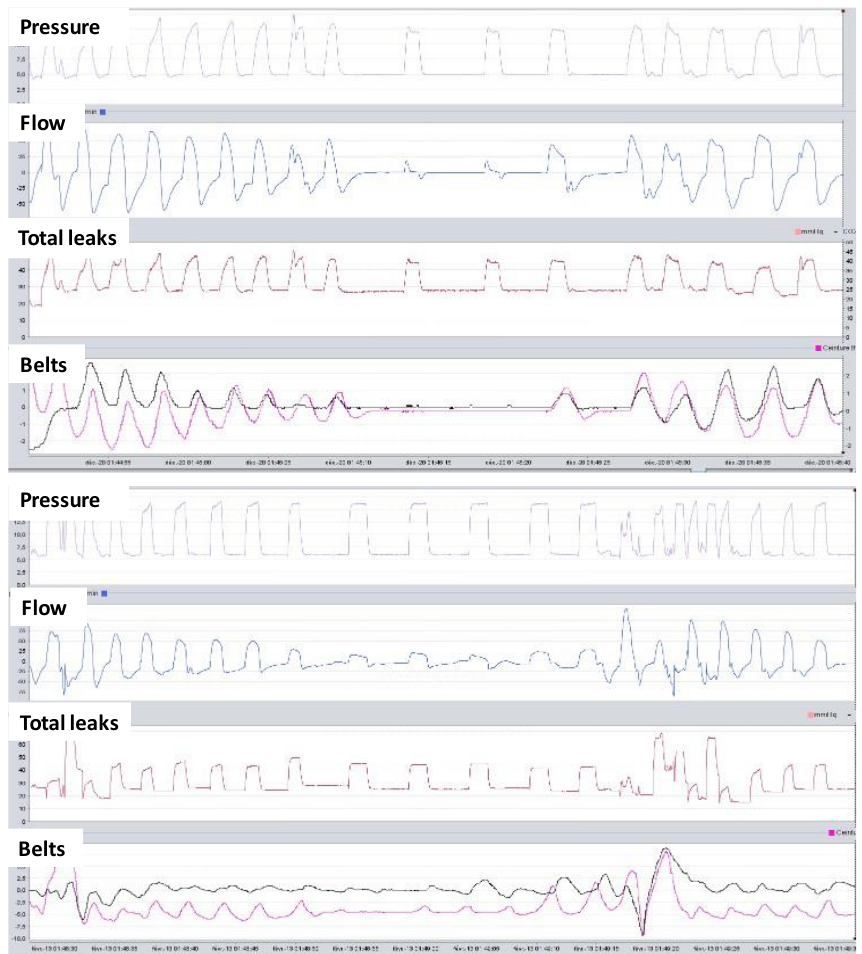
Figure 8. Polygraphy combined with the ventilator. Upper panel shows an upper airway obstruction without unintentional leaks. Belts do not move during the event, suggesting a laryngeal obstruction due to a decrease in the respiratory drive. Lower panel also shows an upper airway obstruction without unintentional leaks. Belts show a phase opposition with a negative inflexion on the thoracic belt (pink) and a positive inflexion of the abdominal belt (black) during the event. This feature suggests a pharyngeal airway obstruction with preserved respiratory drive.